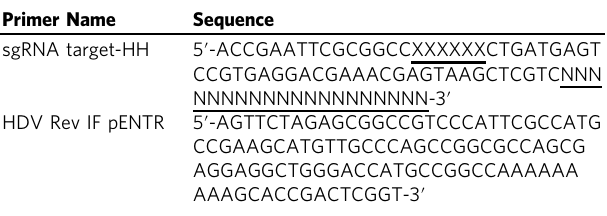
Table 3 Primers used for gRNA cloning in the second